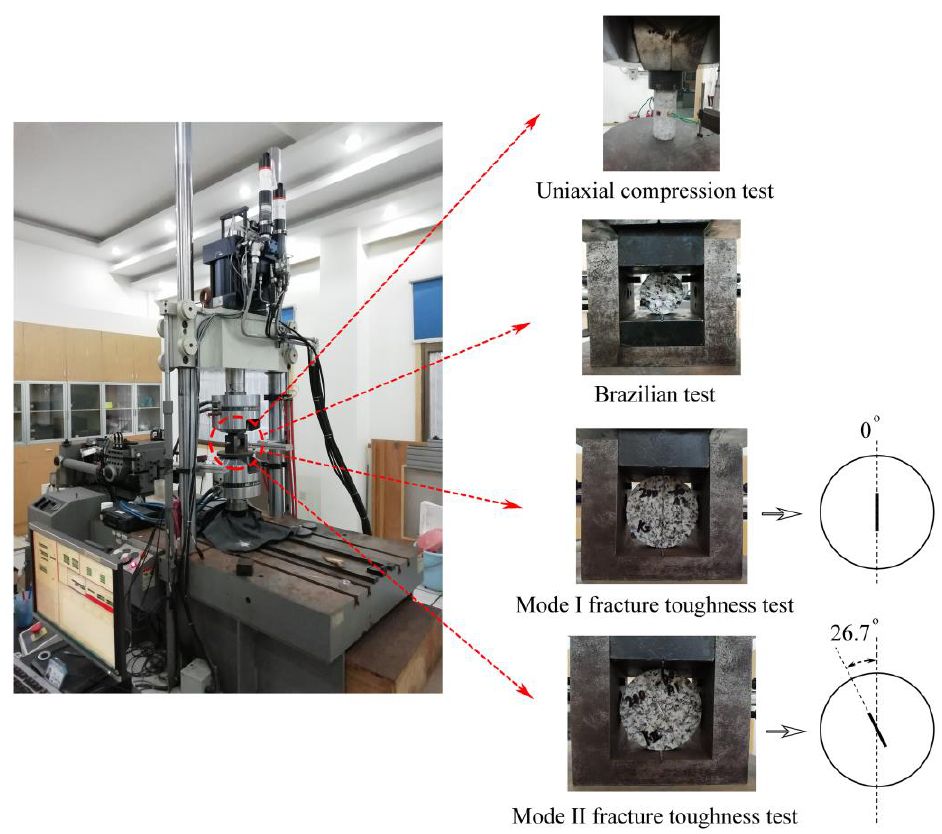
Figure 7. Mechanical tests on the MTS322 servo-controlled rock mechanics test system.